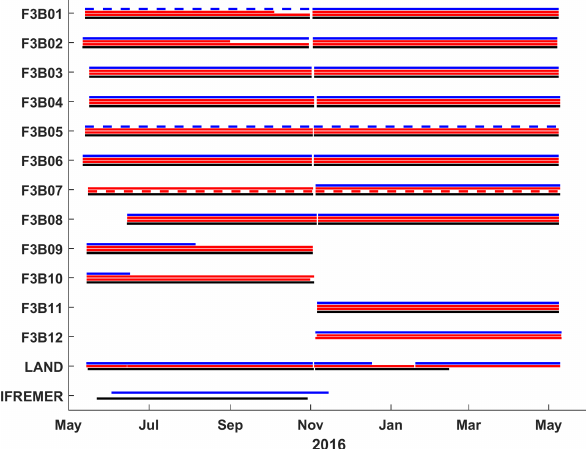
Figure 4. Data return legs 3 and 4. For the moorings F3B01-12, ADCPs are in blue, CTD sensors are in red and UBTIs are in black. The top lines correspond to the shallowest unit. For the land-based stations (LAND), DOGIS SUTRON weather station is in blue, DO- GIS U30 weather station is in red and POOLC SUTRON tide gauge is in black. IFREMER ADCP (SPMGF) and MASTODON (M01- 12) data are in blue and black, respectively. Dashed lines represent partial data recovery (e.g. ADCP tilted, CTD having no or partial salinity